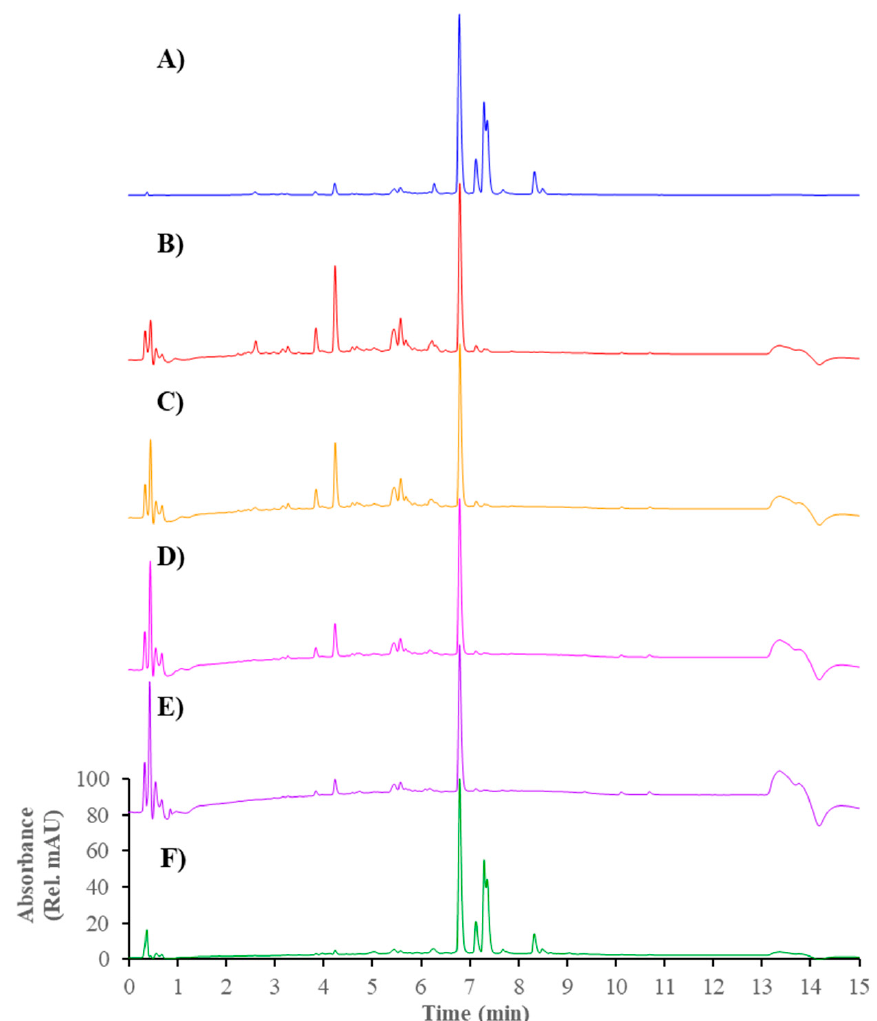
Figure 1. HPLC-UV profiles ( λ = 280 nm) presenting bound and unbound compounds of propolis extract to α -glucosidase. ( A ) Full extract; ( B ) Filtrate; ( C ) Supernatant after 1st washing; ( D ) Supernatant after 2nd washing; ( E ) Supernatant after 3nd washing; and ( F ) Final supernatant.